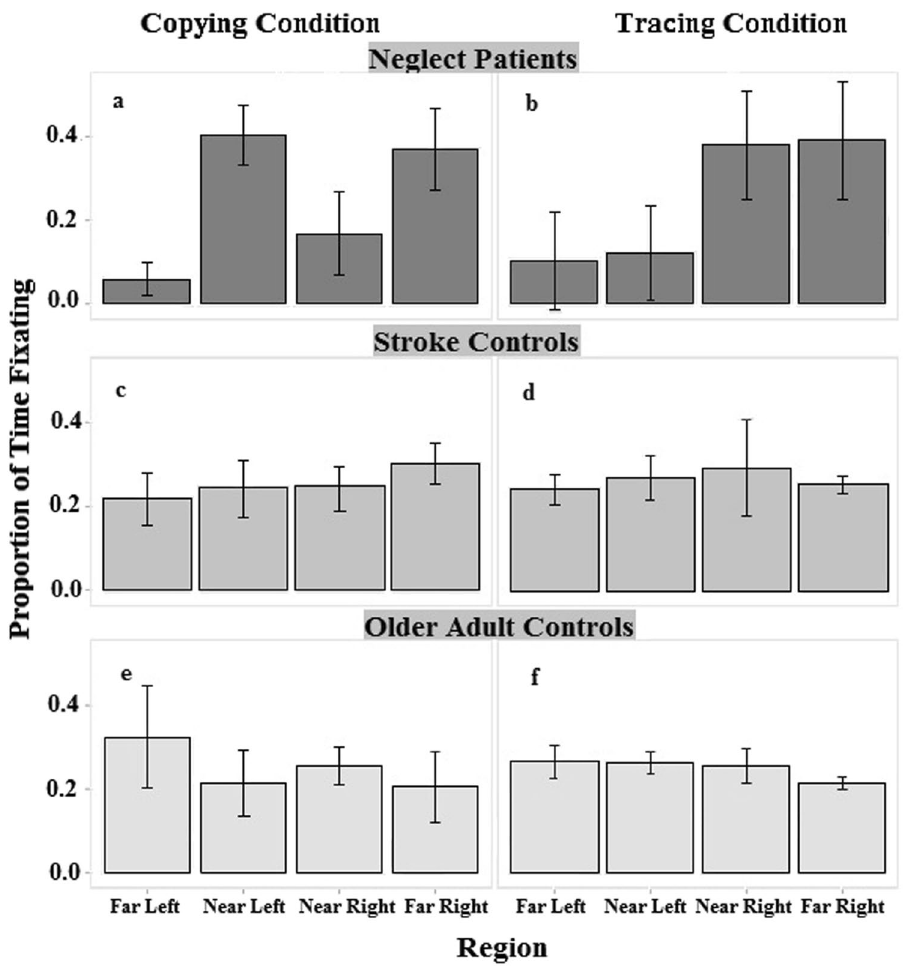
Figure 3. Proportion of the total trial time spent fixating the four regions of the stimulus (Far Left, Near Left, Near Right and Far Right) during the Tracing and Copying Condition for the Neglect Patients (NPs), Older Adult Controls (OACs) and Stroke Controls (SCs). Error bars represent the 95% confidence interval around the mean. The same pattern of behaviour was found for the number of gazes meaure (see Fig. S2 in the Supplementary Information).